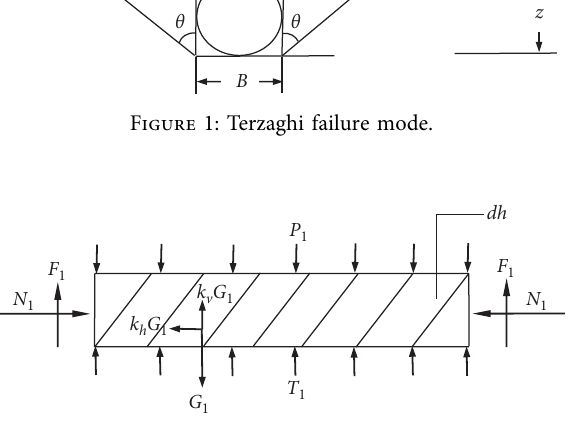
Figure 2: Force diagram of the microunit.